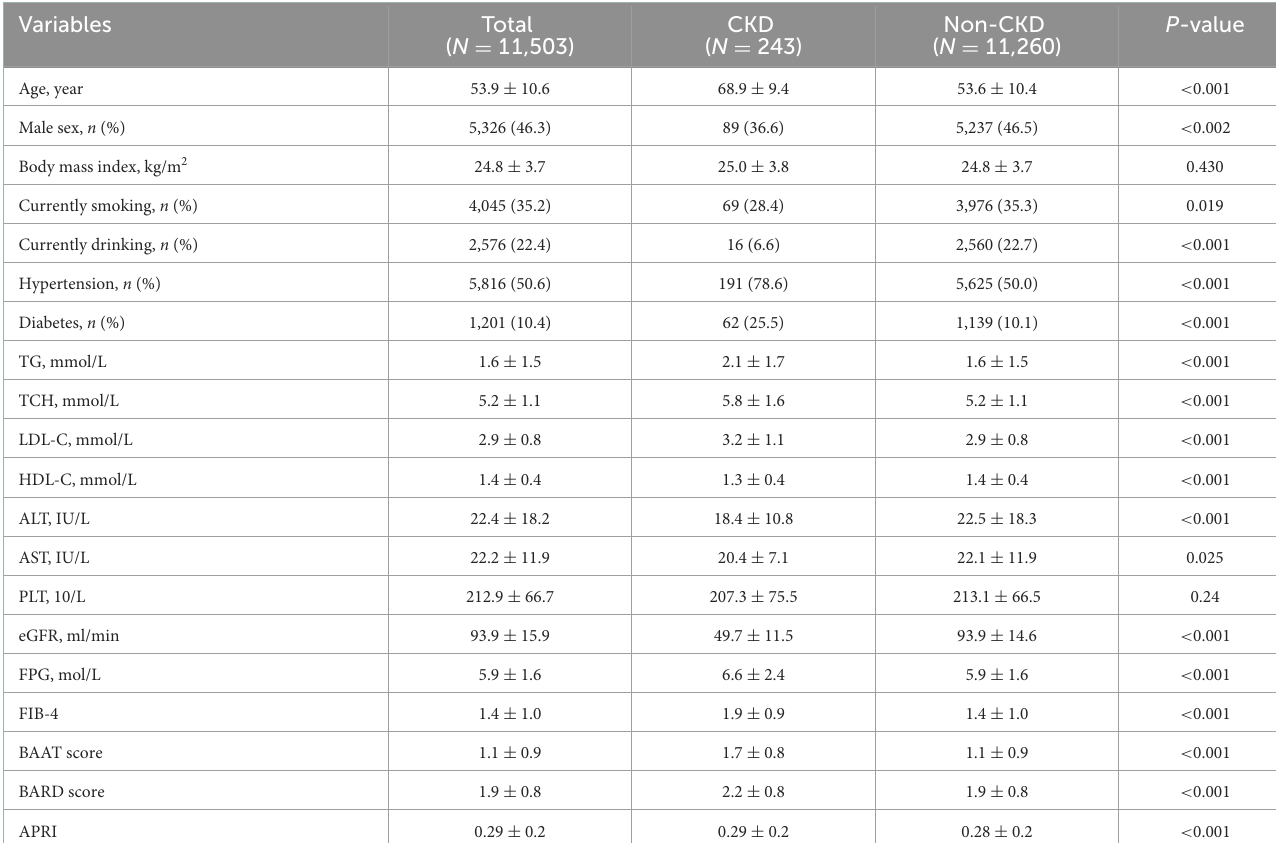
TABLE 1 Baseline characteristics of the study population.